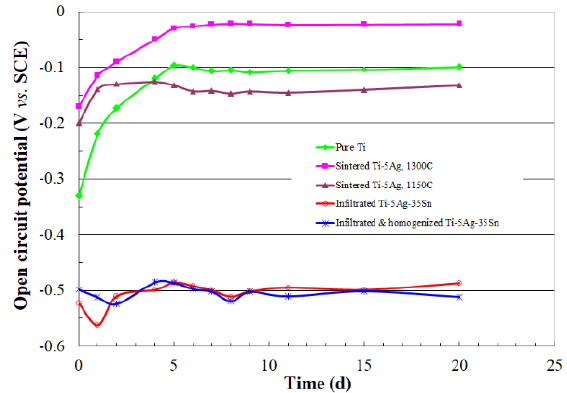
Figure 14. The time dependence of the OCP in saline solution at pH 5.5, T = 37 ◦ C, of CP-Ti as well as of Ti-5Ag and Ti-5Ag-35Sn alloys processed by three-dimensional printing [187]. Reprinted with permission from